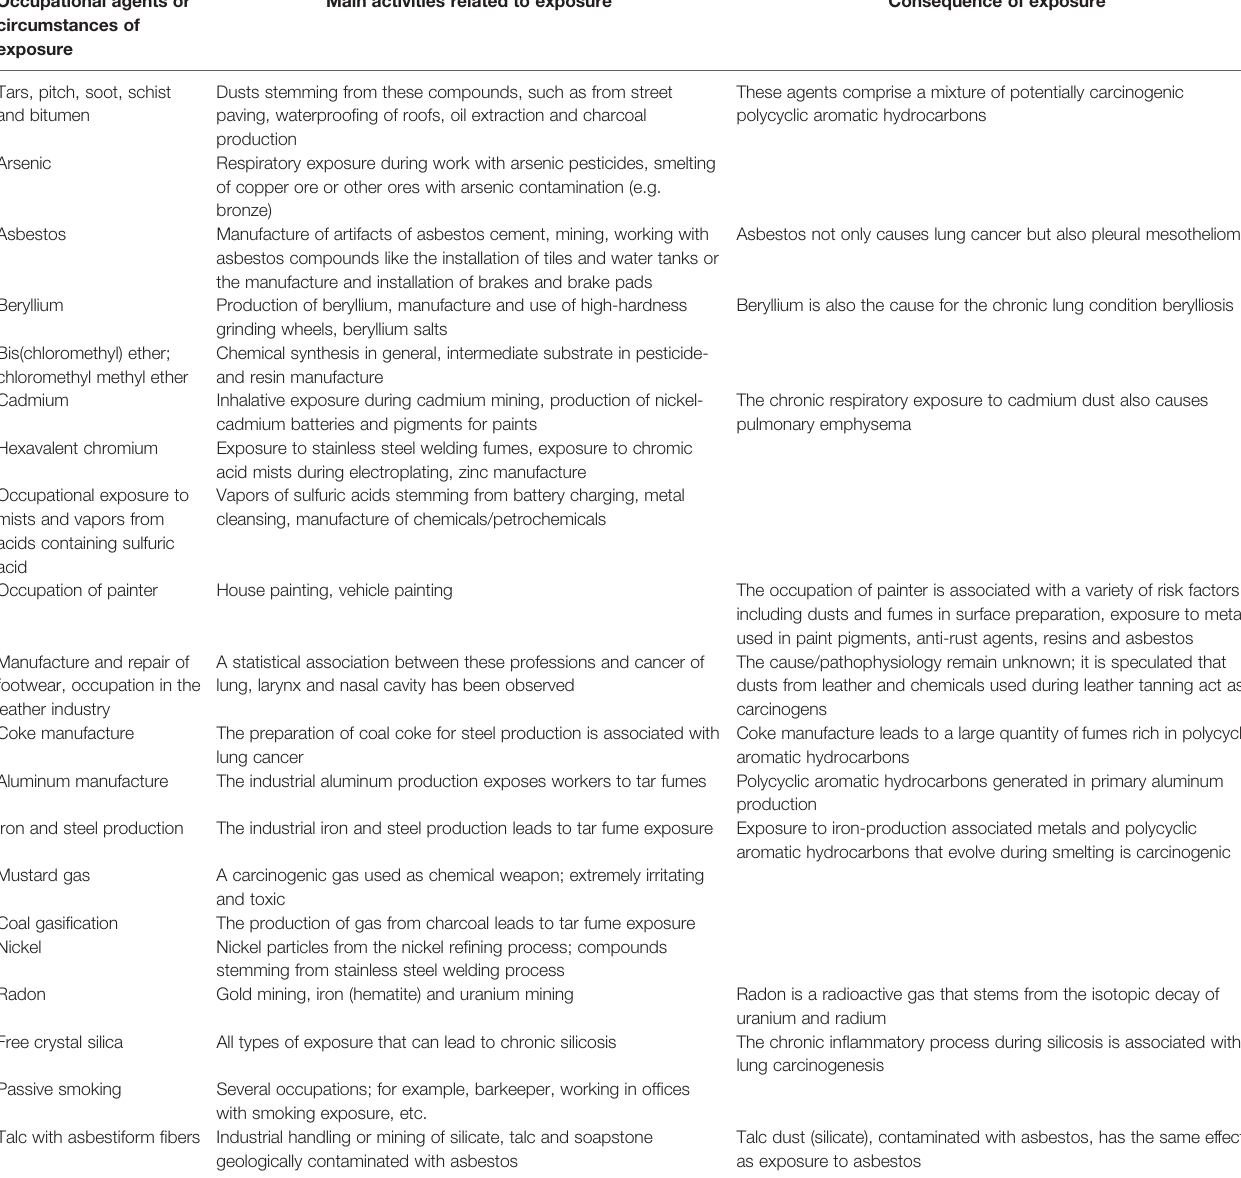
TABLE 1 | Group 1 occupational carcinogens for lung